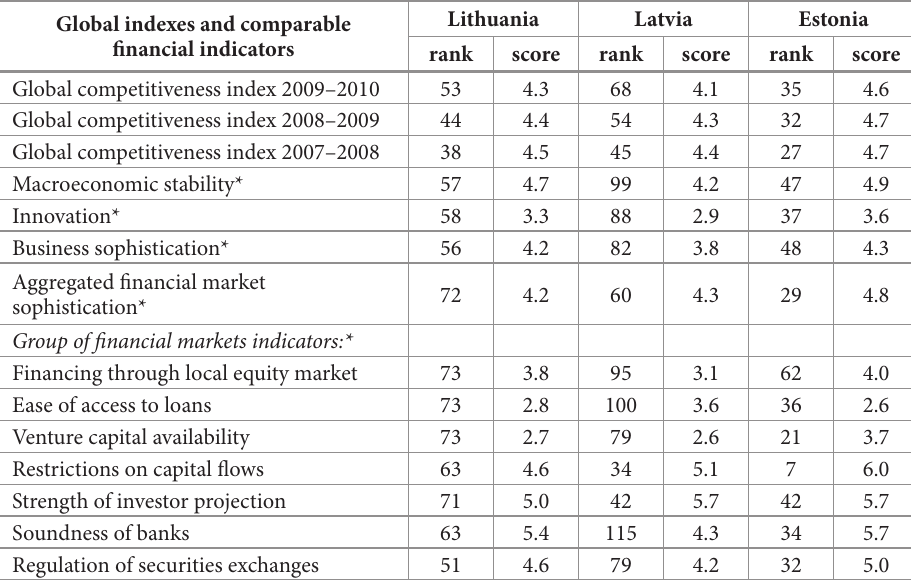
Table 3. The comparative results of assessment of global competitiveness indexes and financial markets sophistication indexes for the Baltic States Global indexes and comparable financial